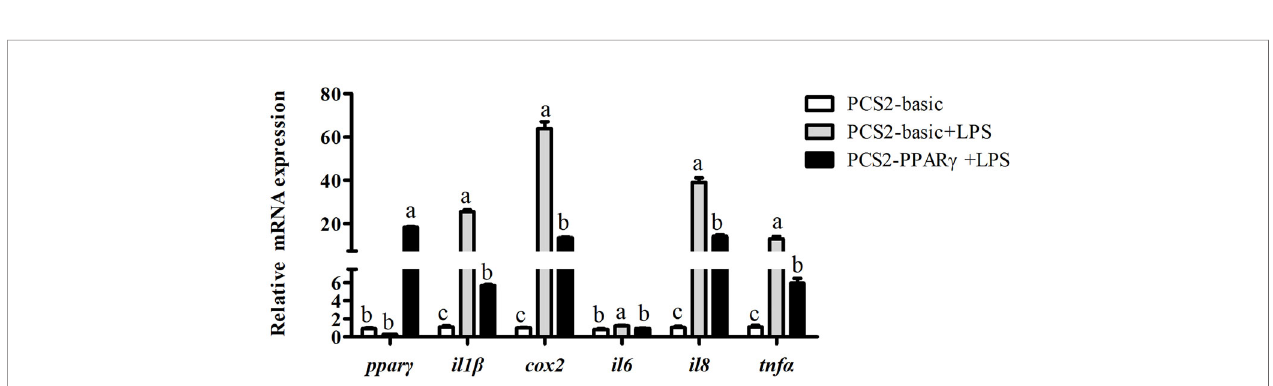
FIGURE 4 | Effects of FFAR4 overexpression on LPS-induced expression of il1 b , il6 , il8 , cox2 , tnf a , ifnh and ppar g in macrophages of large yellow croakers. Values were shown as mean ± S.E.M. (n = 4). For each gene, values in bars bearing the same letters were not signi fi cantly different among treatments ( P > 0.05).